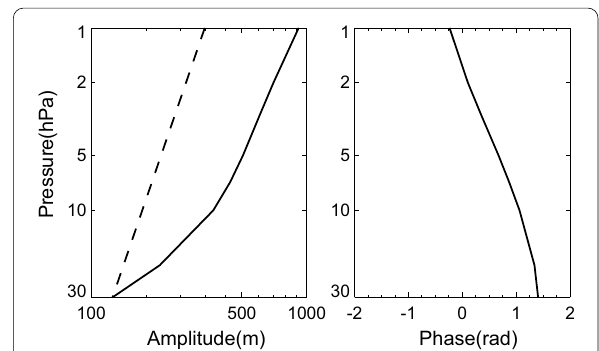
Fig. 9 The amplitudes (left) and phases (right) for the geopotential height at 65 ◦ N . The dashed black line (left) denotes the theoretical expectation of the Lamb